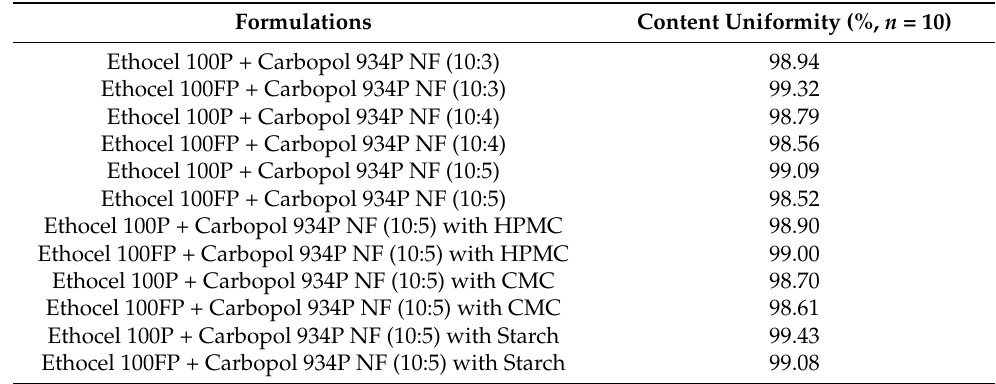
Table 4. Content uniformity of various